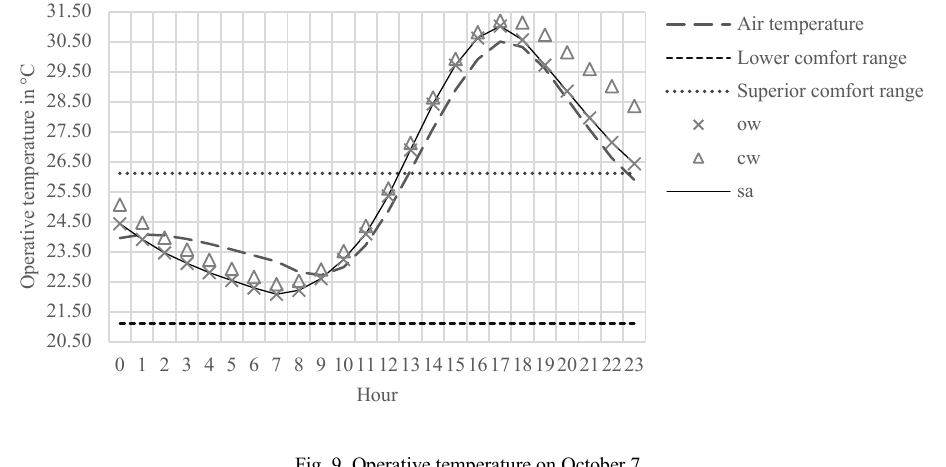
Fig. 9. Operative temperature on October 7.